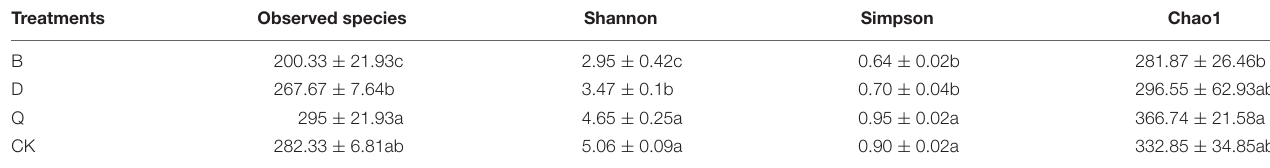
TABLE 2 | The richness and diversity index of fungi community in different rotation vegetables and continuous tomato were analyzed and observed.